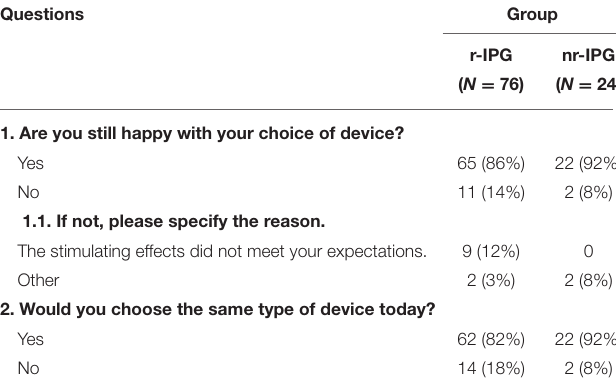
TABLE 2 | Satisfaction